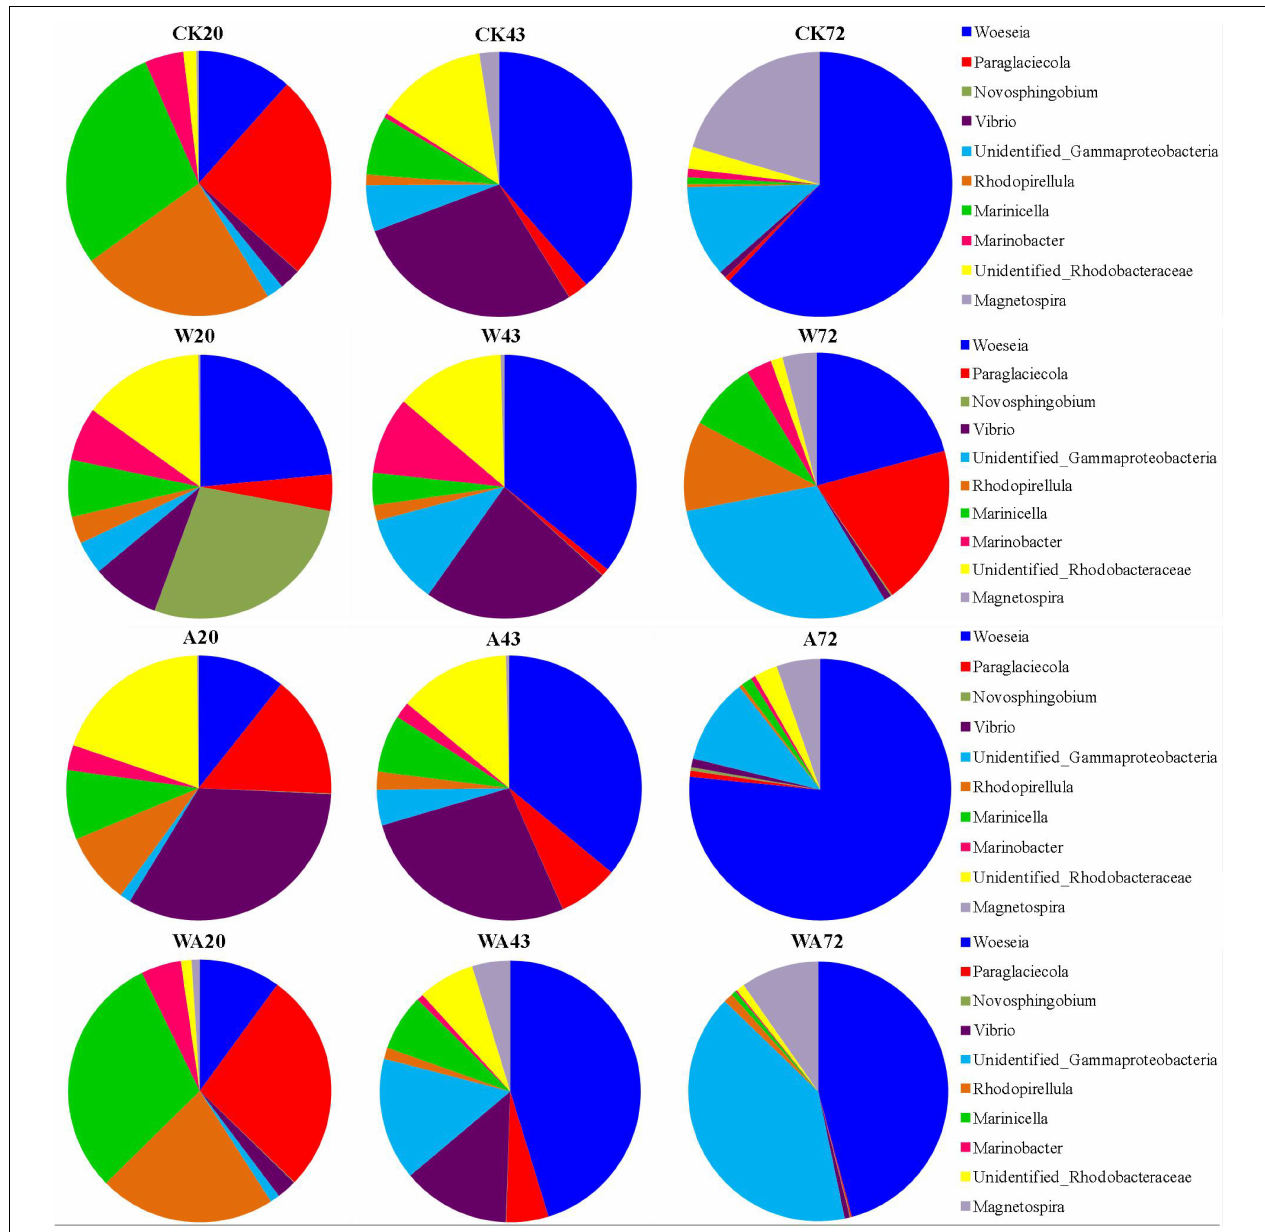
FIGURE 3 | Changes in composition of bacterial communities in the Apostichopus japonicus culture tank at the genus level (%). CK, control; W, warming treatment; A, acidification treatment; WA, acidification and warming treatment. 20, 43, and 72: samples were collected at 20, 43, and 72 days.